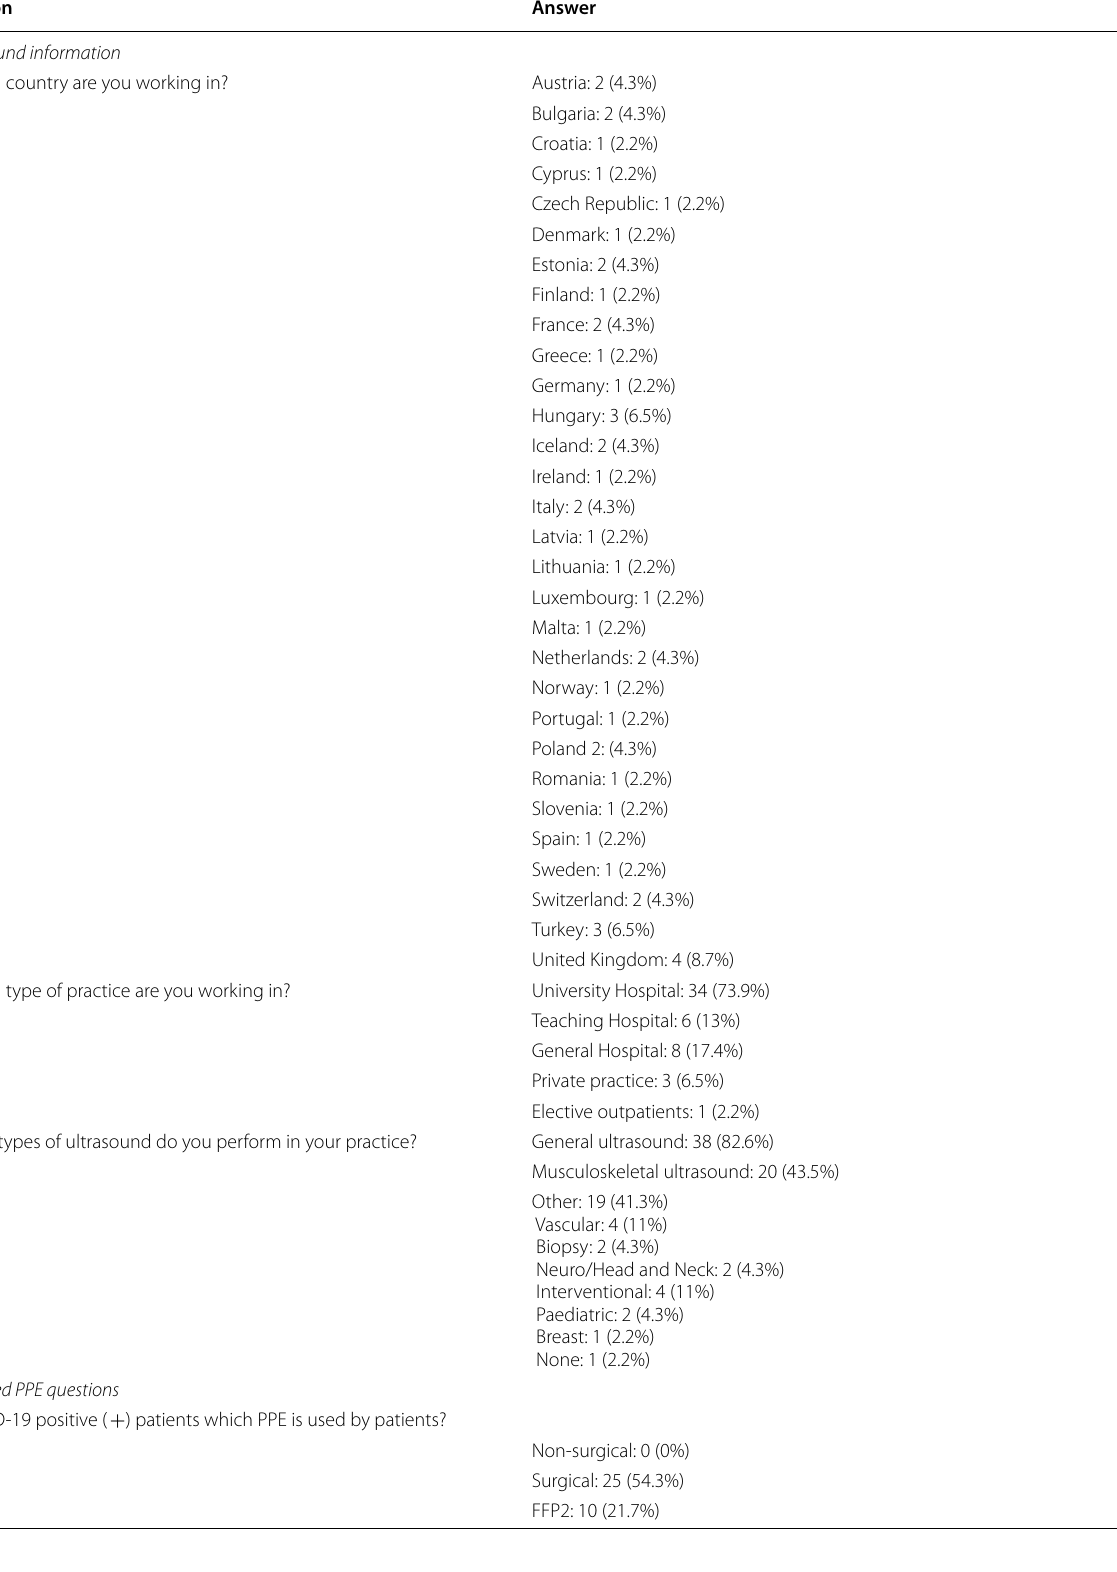
Table 1 Full list of questions included in the survey and answers from 46 respondents